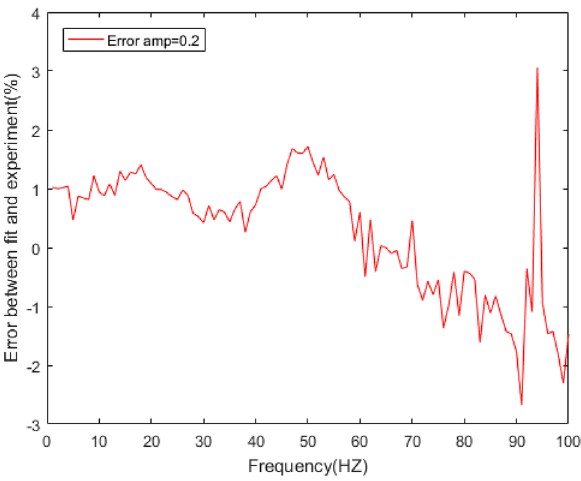
Figure 22. Errors of loss factor between five-parameter mathematical model and experiment under amplitude 0.2 mm.